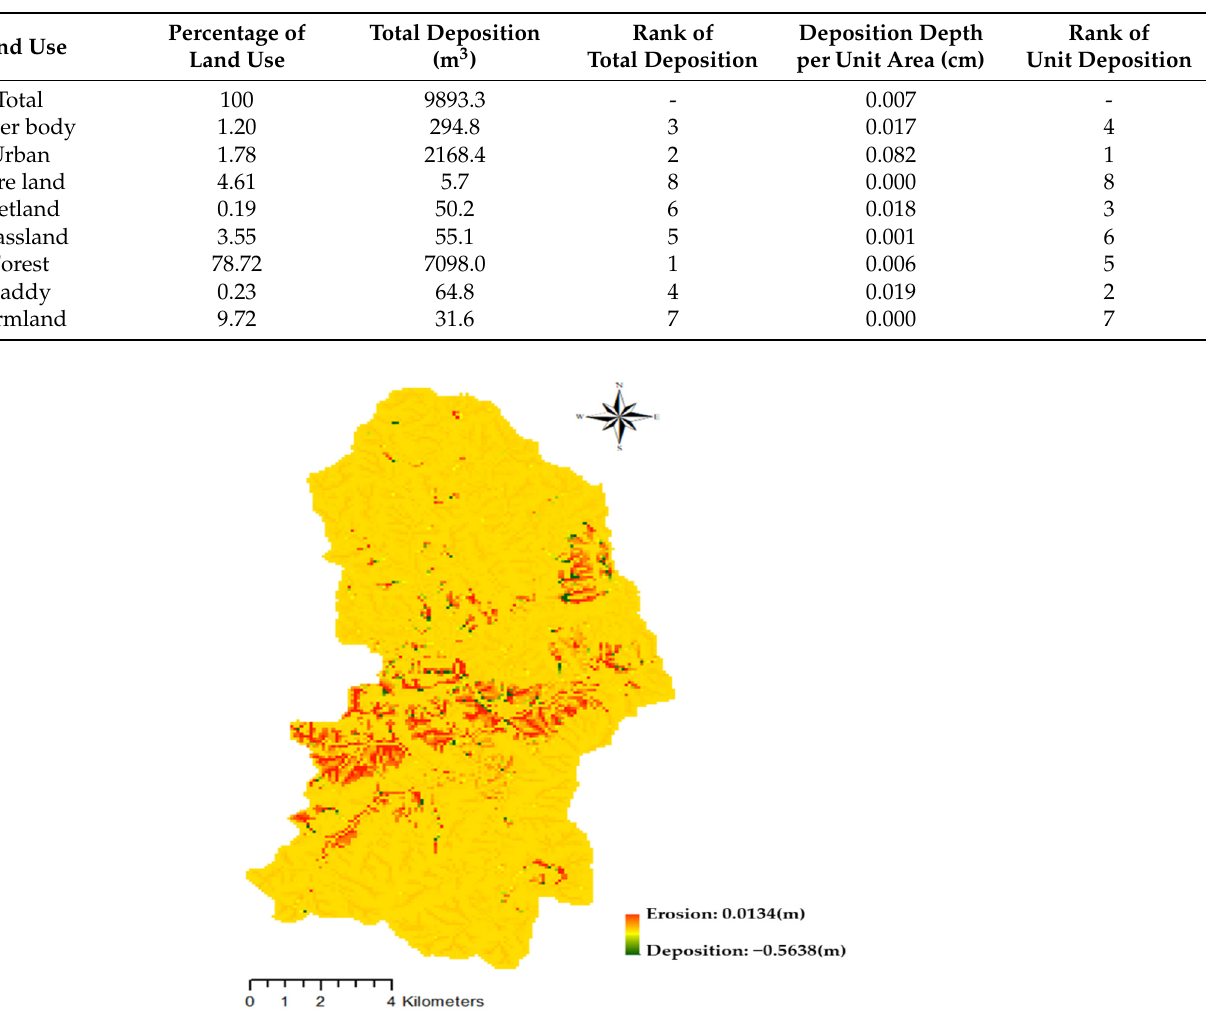
Table 9. Results of deposition for land use (the calibrated MR-SSEM, Typhoon Maemi).